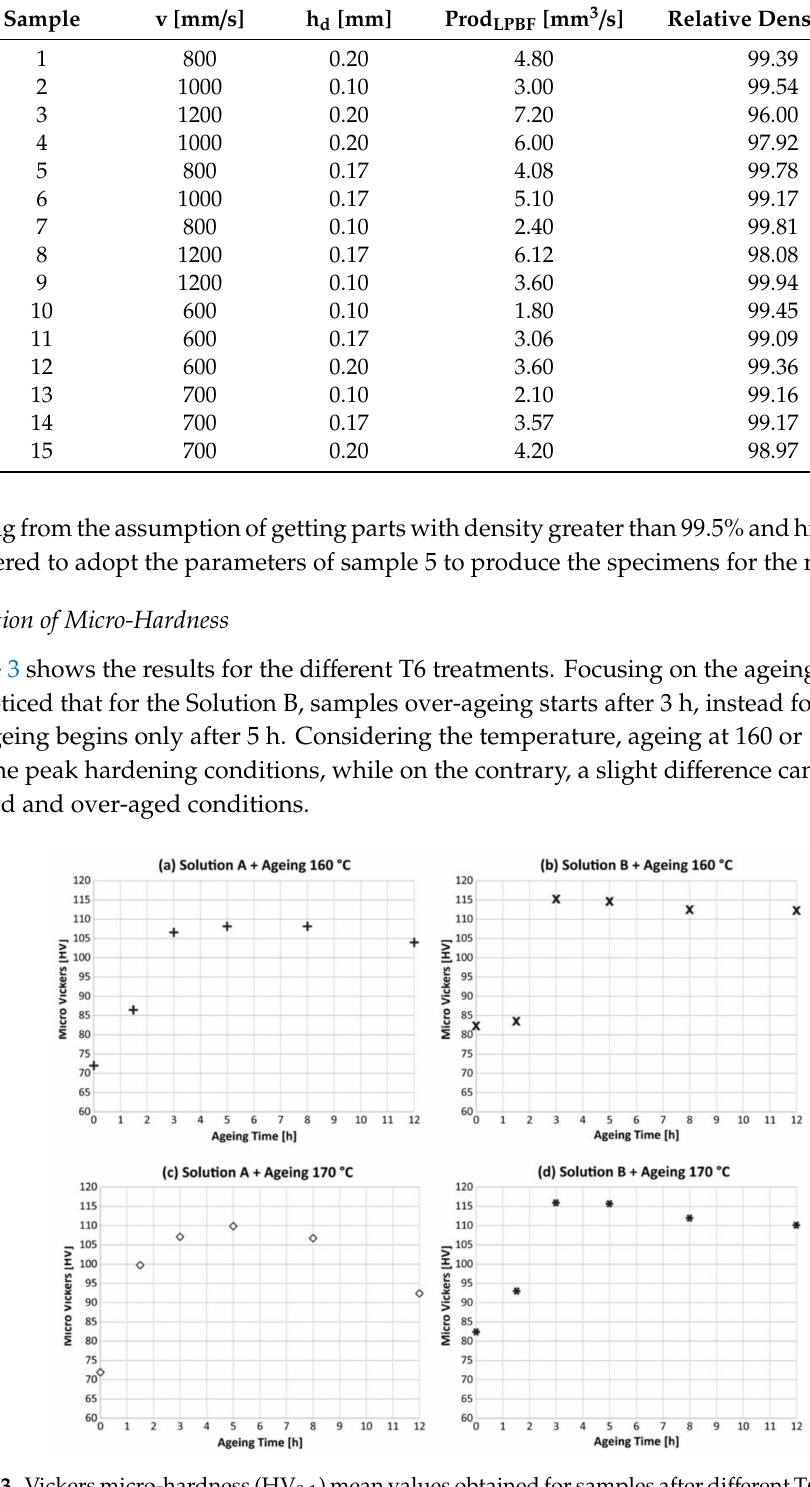
Figure 3. Vickers micro-hardness (HV 0.1 ) mean values obtained for samples after di ff erent T6